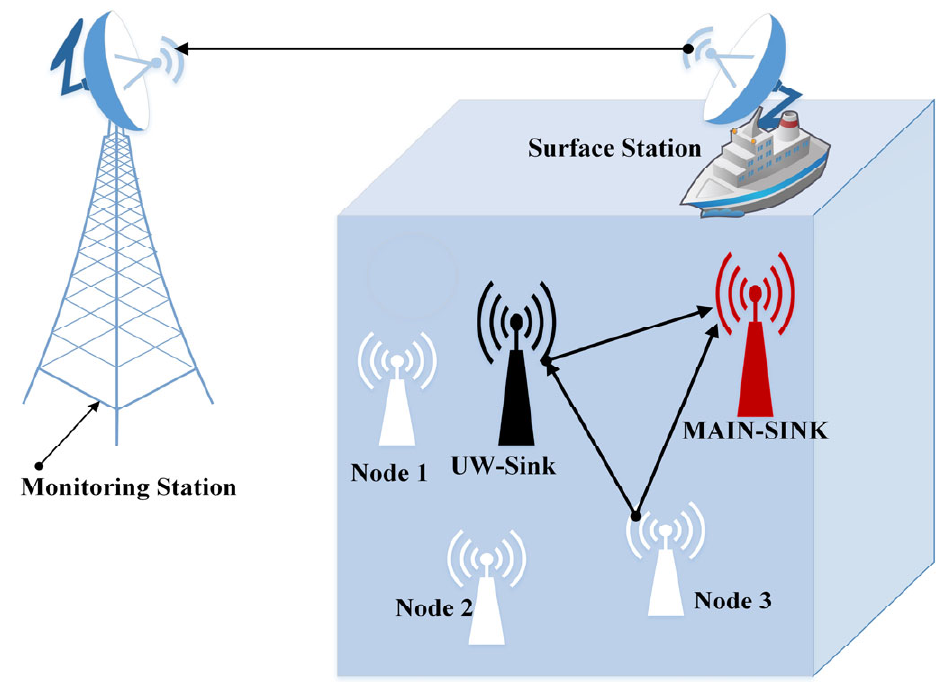
Figure 5. Buffring_Slotted_ALOHA protocol topology [44].